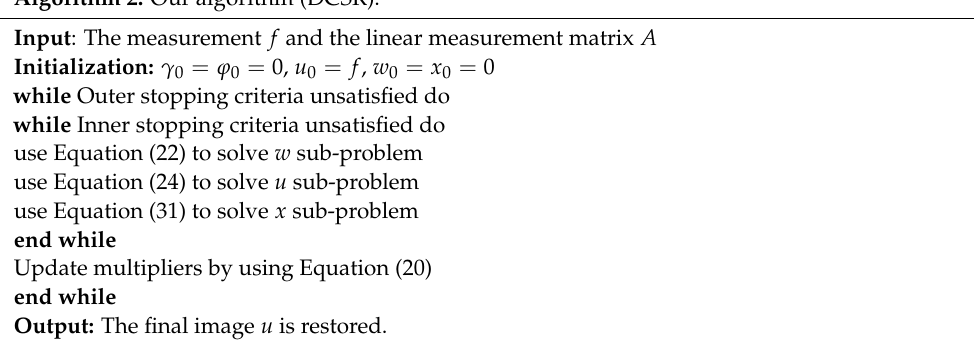
Algorithm 2: Our algorithm (DCSR).